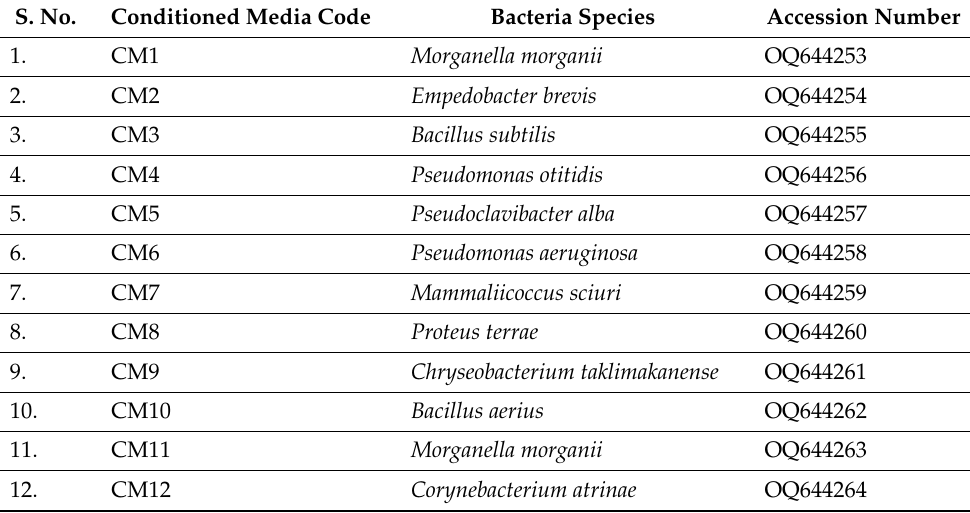
Table 1. Bacterial species isolated from the gut of water monitor